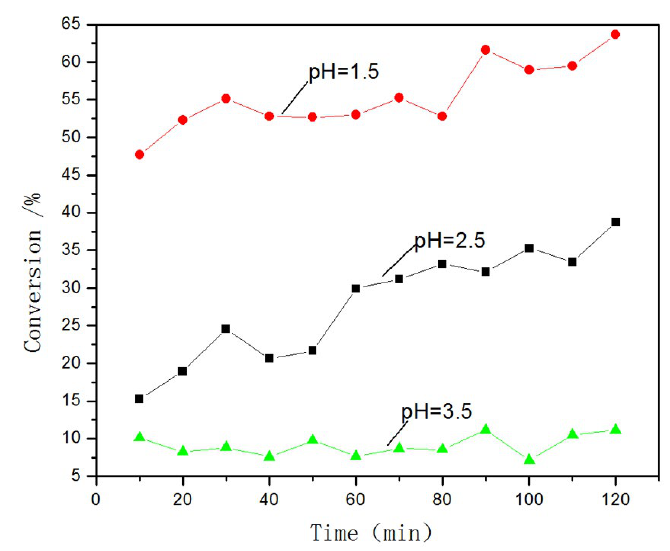
Fig. 3. Effect of pH values on the microemulsion Table 4 Effect of emulsifier on the microemulsion Table 4. Effect of emulsifier on the microemulsion Emulsifier OP-10